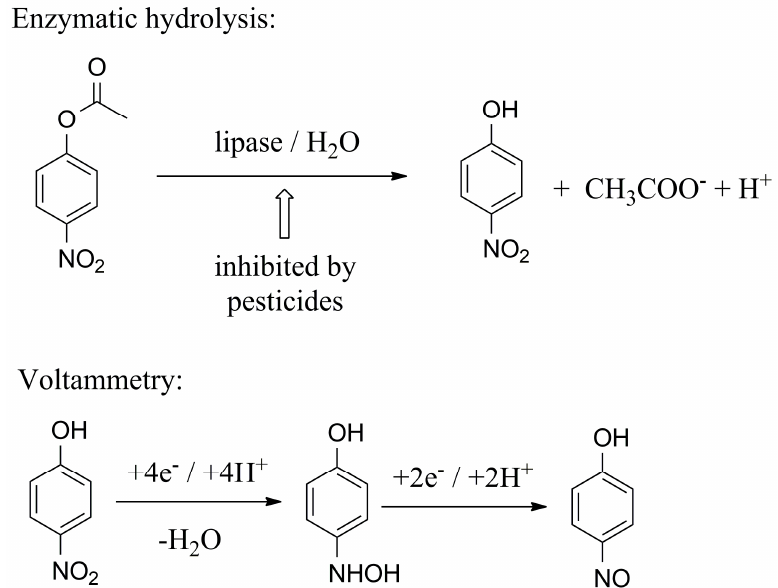
Figure 5. The principle of voltammetry for the determination of lipase inhibitors like malathion, parathion and chlorfenvinphos using p -nitrophenyl acetate as the substrate for the enzyme. Table 3. The overview of lipase-based electrochemical